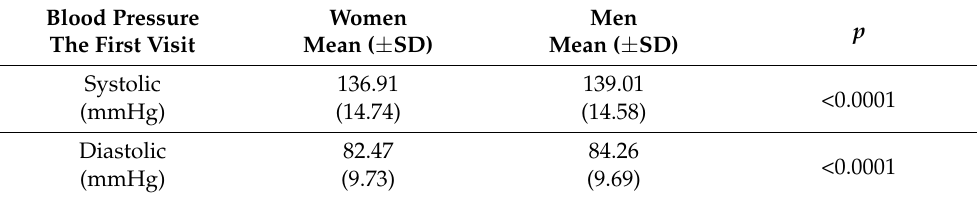
Table 2. Comparison of blood pressure between men and women at the first visit.